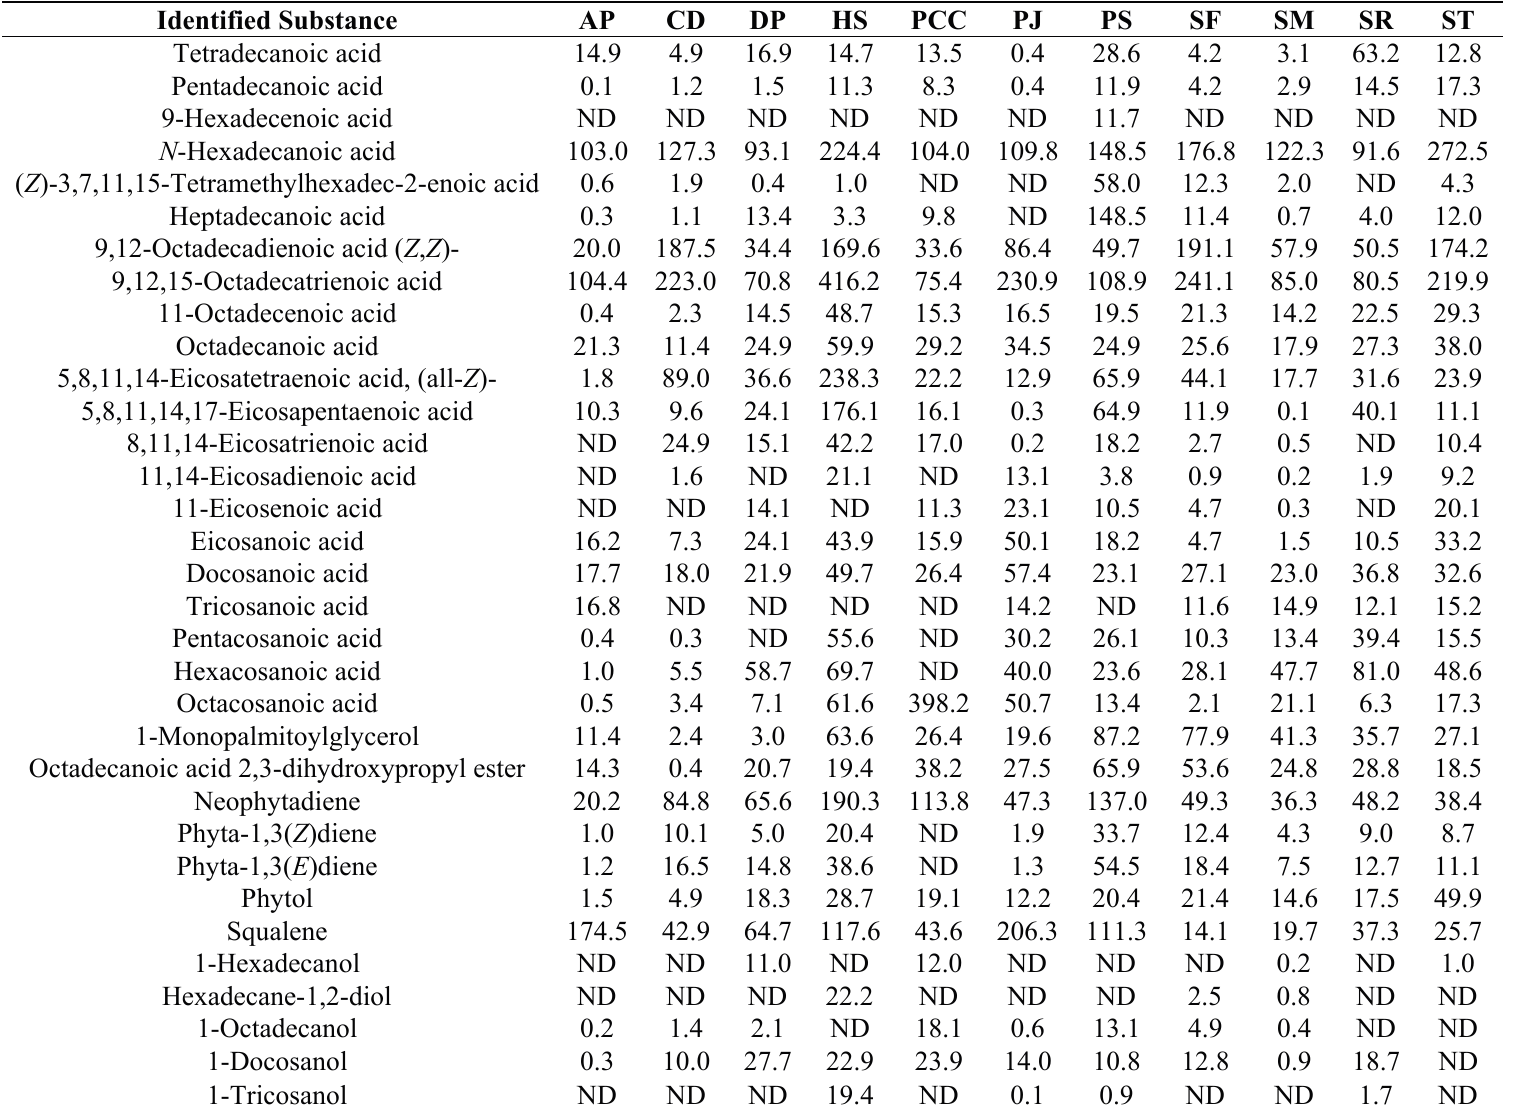
Table 4. Concentrations (mg/100 g dry weight) of substances from the chloroform extracts of the studied mosses according to the GC/MS